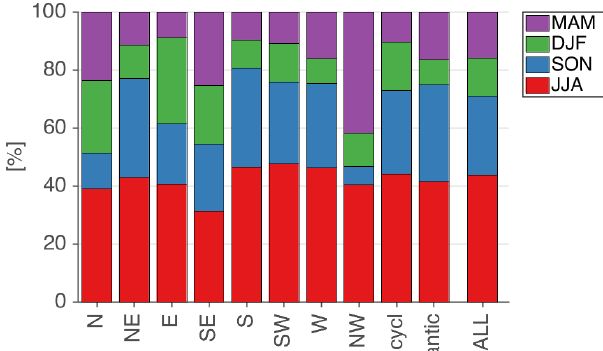
Figure 10. Distribution of seasons in the studied data set for each weather type. Only time periods when a P-MPC was present are in- cluded to evaluate the possible impact of wind direction seasonality on cloud properties and